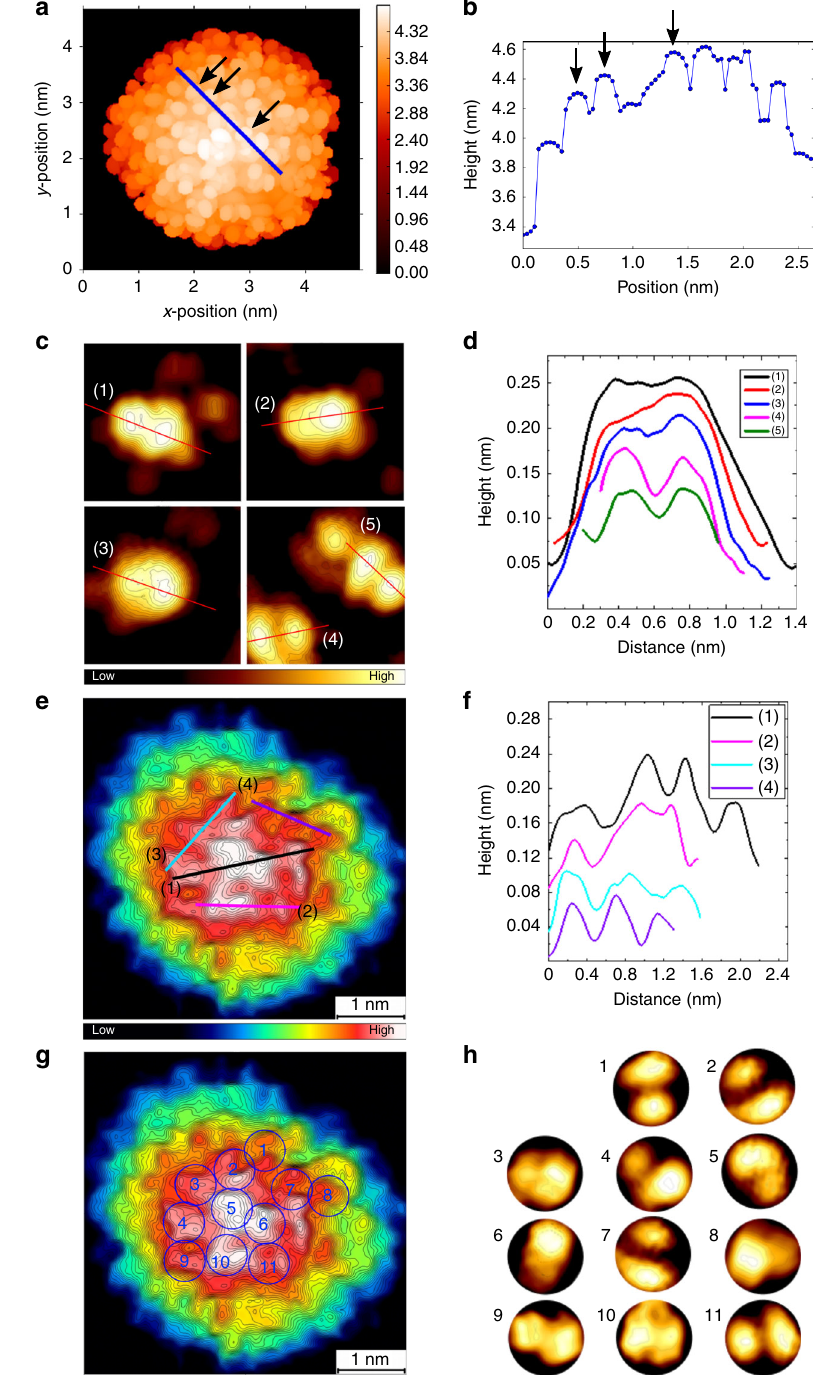
Fig. 3 DFT simulations and high-resolution imaging. a DFT calculated STM image for Ag 374 by using the known atomistic structure of the nanocluster 17 . Image area: 5 × 5 nm 2 . The image has been simulated by using voltage and current settings of − 1.4 V and 20 pA, respectively. Black arrows indicate individual methyl groups. b Height pro fi le taken along the blue line in a . The three arrows show positions of the same methyl groups as shown in a . c STM topography images of single TBBT molecules in various orientations bound to an Au(111) surface. Image settings: ( 1 , 2 ) 1.0 V, 30 pA, 1.51 × 1.51 nm 2 ; ( 3 – 5 ) 1.2 V, 60 pA, 1.50 × 1.50 nm 2 , all at LN 2 temperature. (Zoomed in from different large images, the resolution had small deviation.) d shows height scans of the molecules as marked in c by numbers 1 – 5. e A topography image of Ag 374 at submolecular resolution (bias: − 1.2 V, current: 10 pA, scan size: 4.81 × 4.81 nm 2 ). f Height pro fi les of the cluster along the lines marked in e . g The same cluster as in e , with 11 detailed features showing similarity to the ligand con fi gurations at Au(111) shown in h . STM imaging at LHe